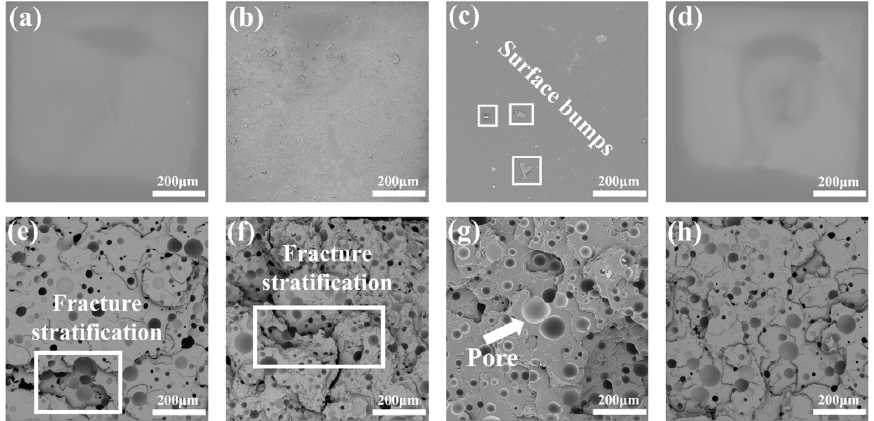
Figure 7. SEM before the surface of polyurea fracture at different pressure under the same temperature: ( a ) 12.42 MPa; ( b ) 15.53 MPa; ( c ) 17.25 MPa; and ( d ) 18.98 MPa. SEM after the cross- section of polyurea fracture t different pressure under the same temperature: ( e ) 12.42 MPa; ( f ) 15.53 MPa; ( g ) 17.25 MPa; and ( h ) 18.98 MPa.